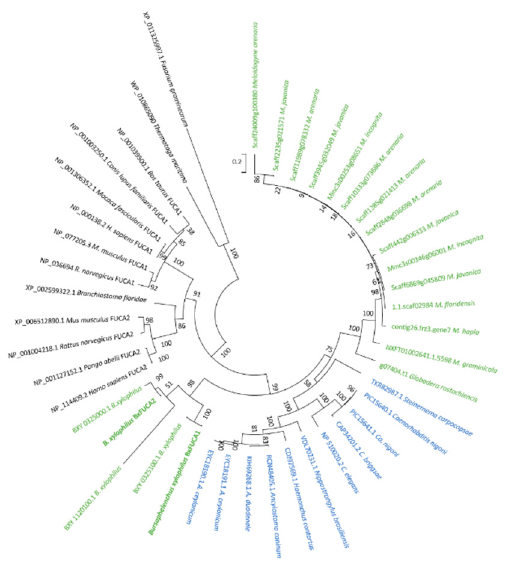
Figure 4. Phylogenetic analysis of predicted Bursaphelenchus xylophilus α - L -fucosidases. The maximum